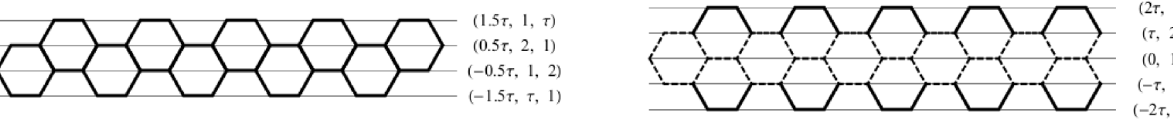
made out of 10 hexagons (see Fig. 4), one gets the polytope C 70 . It